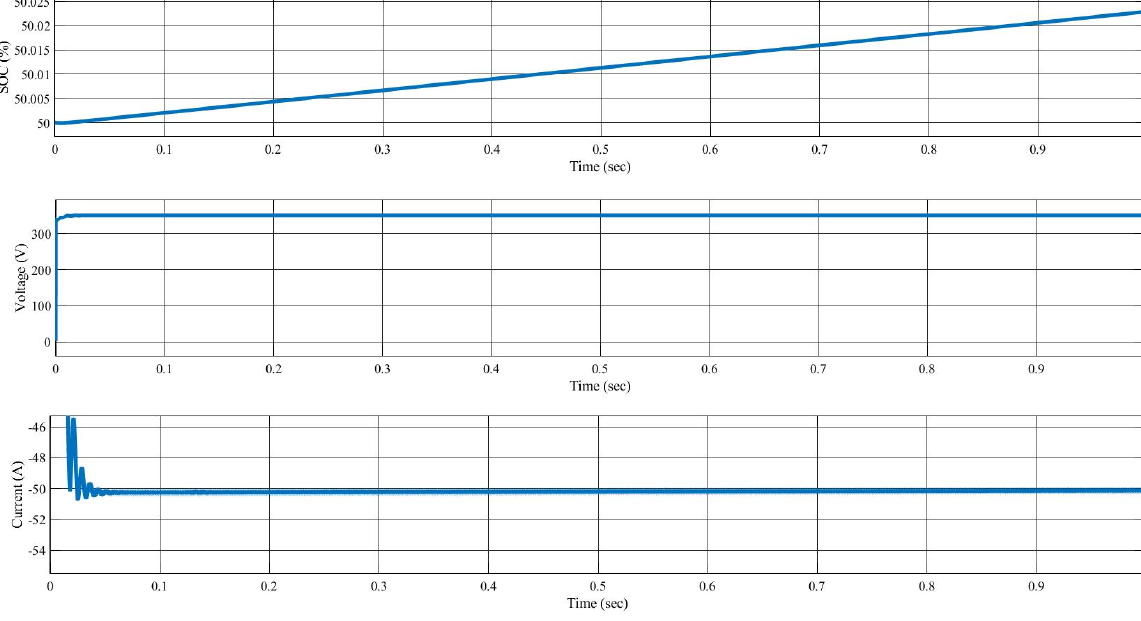
Figure 16. Charging the EVs from both sources simultaneously.